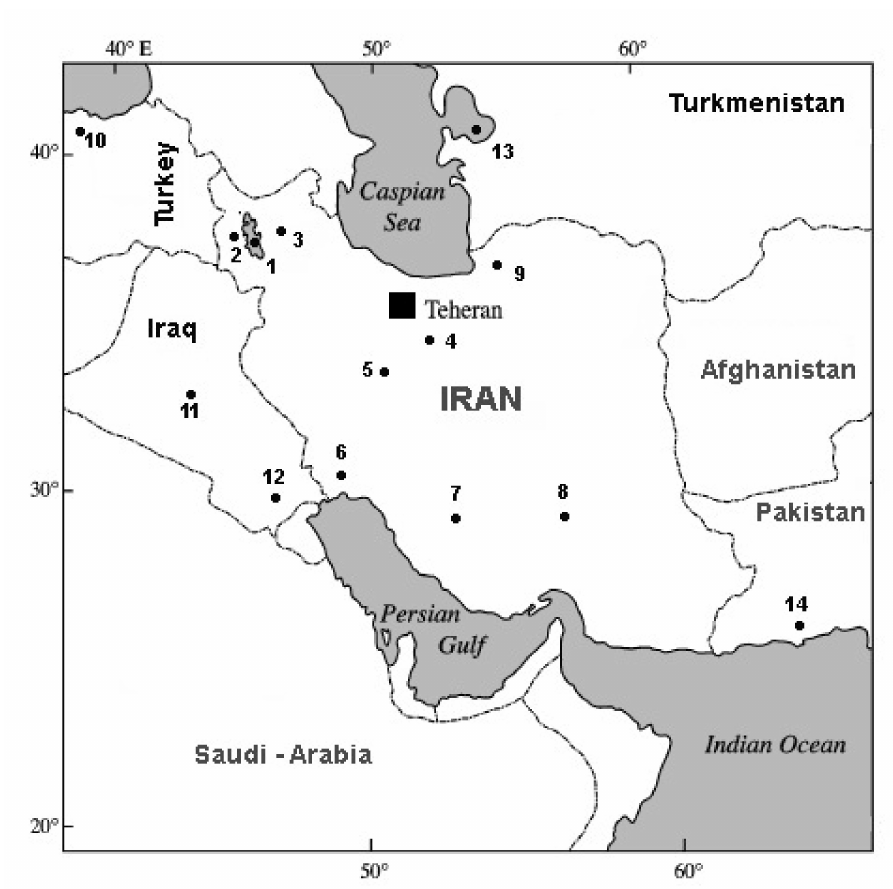
Figure 1. Map of Artemia sampling sites (1 = URM, 2 = LAGW, 3 = LAGE, 4 = QOM, 5 = MIG, 6 = MSH, 7 = MAH, 8 = NOG, 9 = INC, 10 = CAM, 11 = ABG, 12 = GAA, 13 = KBG, 14 = KOC; Abbreviations are listed in Table